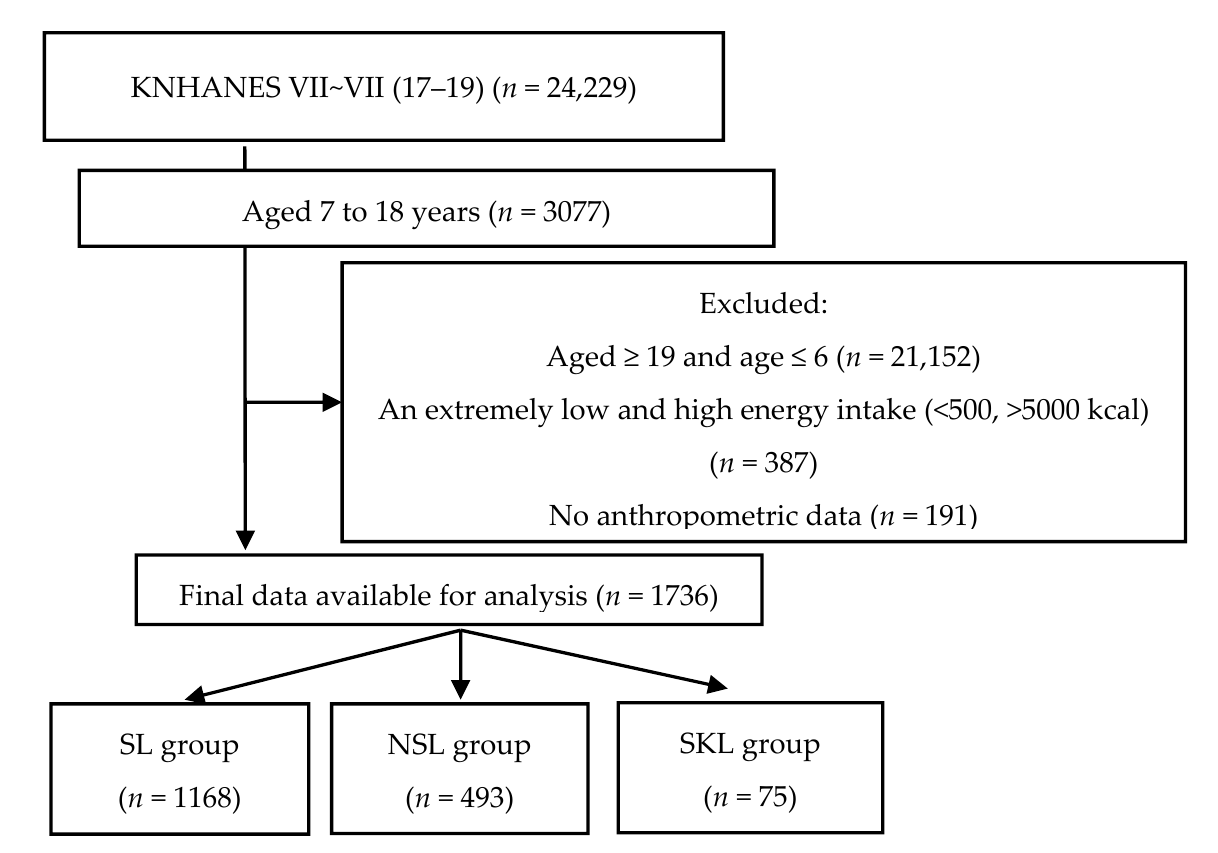
Figure 1. Flowchart of this study. KNHANES, Korean National Health and Nutrition Survey; SL, school lunch; NSL, non-school lunch; SKL, skipping lunch.